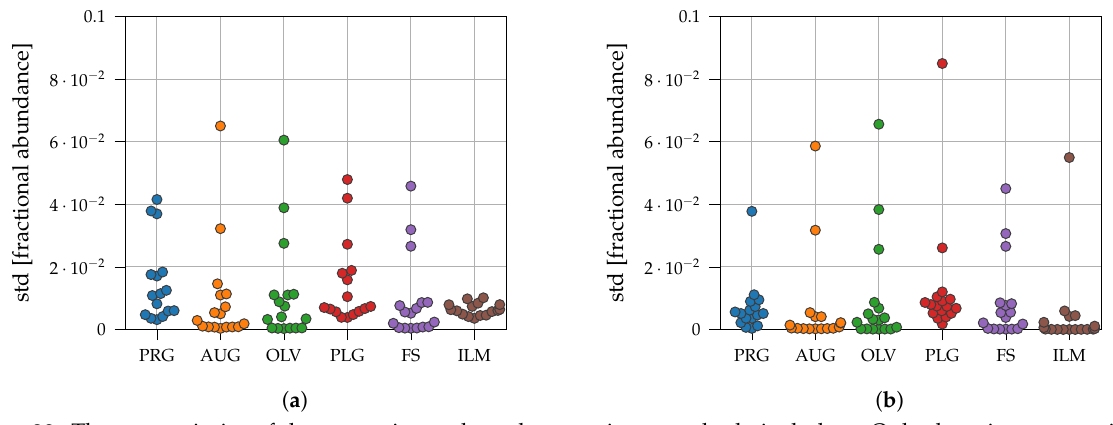
Figure 20. The uncertainties of the respective endmembers are in general relatively low. Only the mixture containing ilmenite and ferrosilite is highly uncertain. For that particular sample, no good solution has been found considering the prior on the sum of the endmember weights. ( a ) Without prior; ( b ) TiO 2